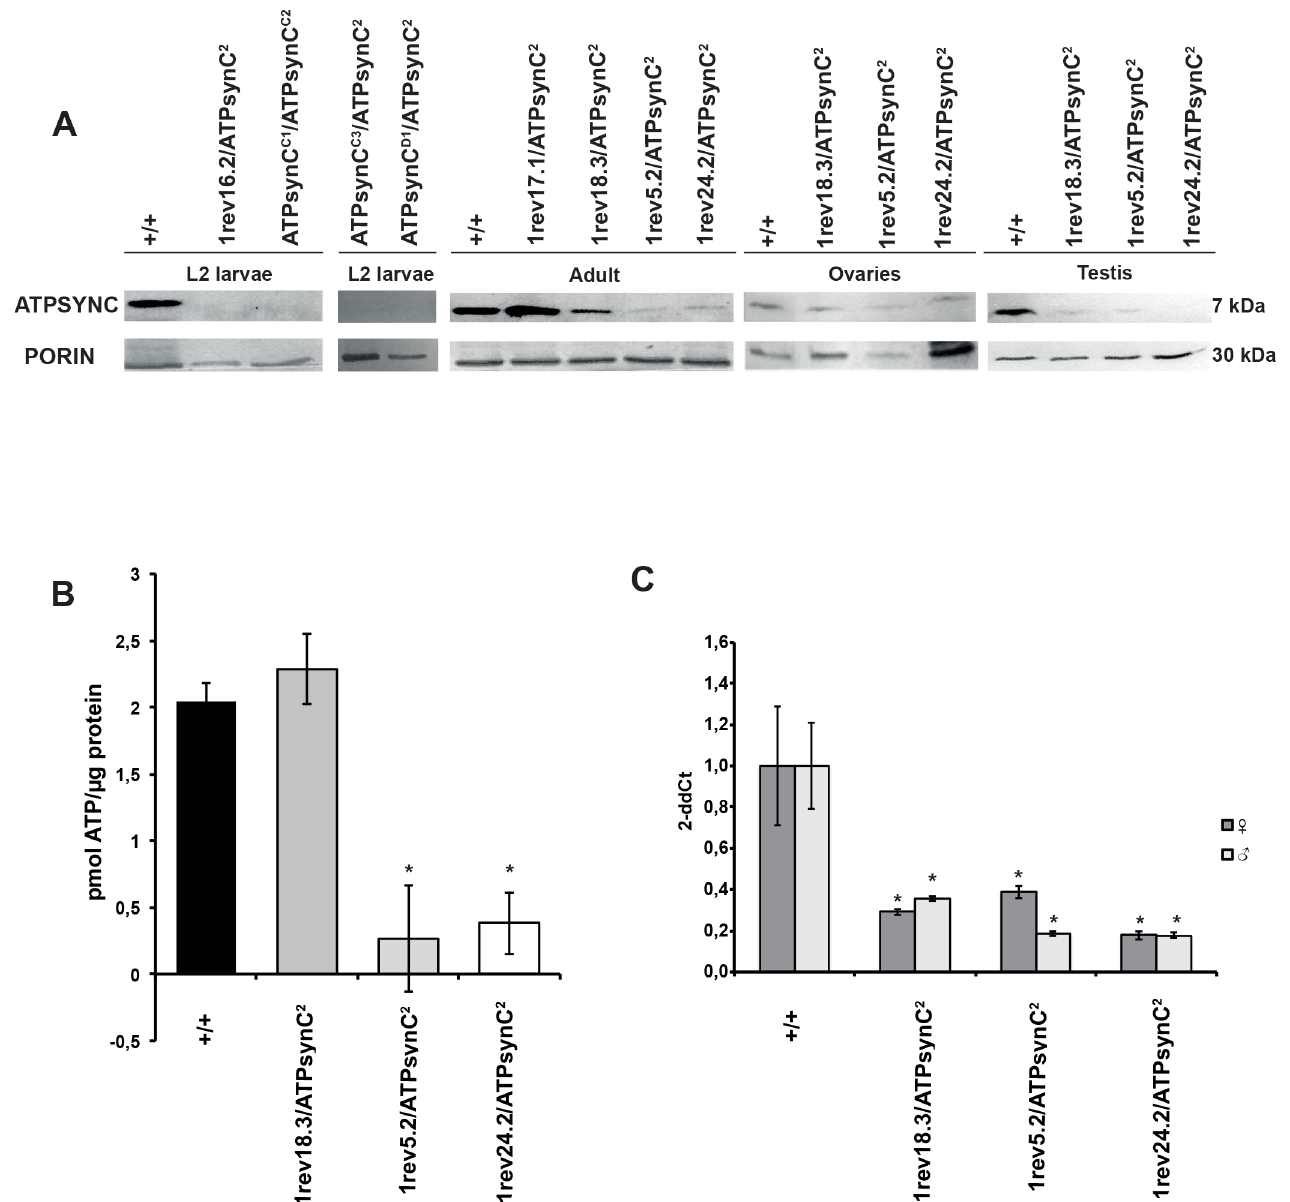
Fig 6. Molecular analyses of ATPsynC mutant alleles. (A) Western blot analyses of trans-heterozygotes for the ATPsynC mutations at critical stages and tissues during development. (B) ATP levels in whole-body lysates from control flies and trans-heterozygotes for the pleiotropic mutations of ATPsynC . (C) ATPsynC mRNA levels, measured by quantitative reverse transcription PCR (RT-qPCR), in control flies and trans-heterozygotes for the pleiotropic mutations of ATPsynC . Statistical significance codes (comparison to wild-type): (cid:3) P < 0.05; (cid:3)(cid:3) P < 0.01; (cid:3)(cid:3)(cid:3) P < 0.001. +/+ = Oregon-R flies.